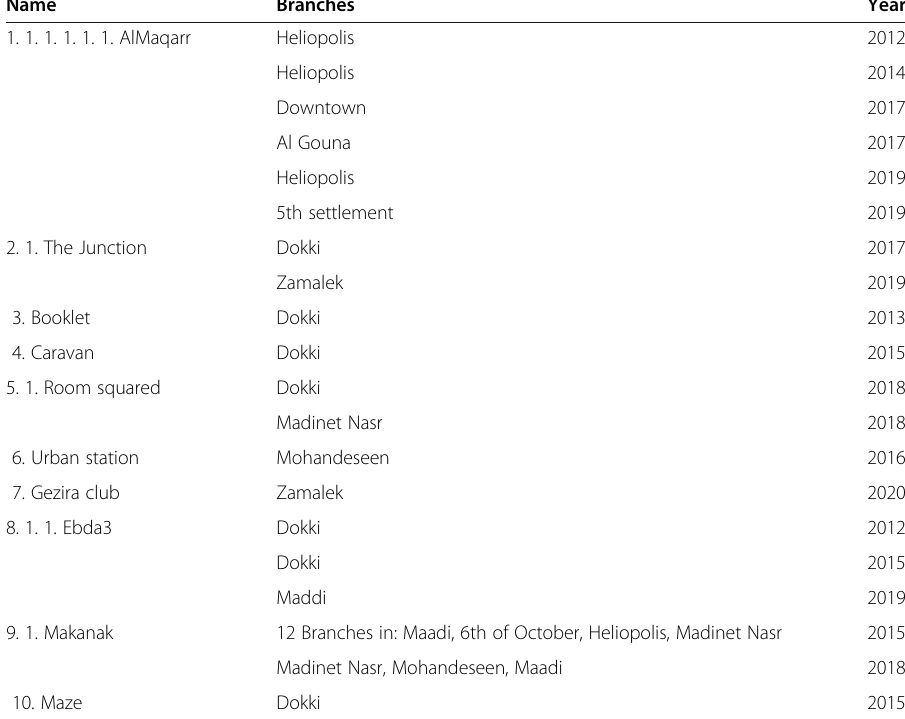
Table 1 Year of establishment of co-working spaces used for the study. Source: elaboration by the authors Name